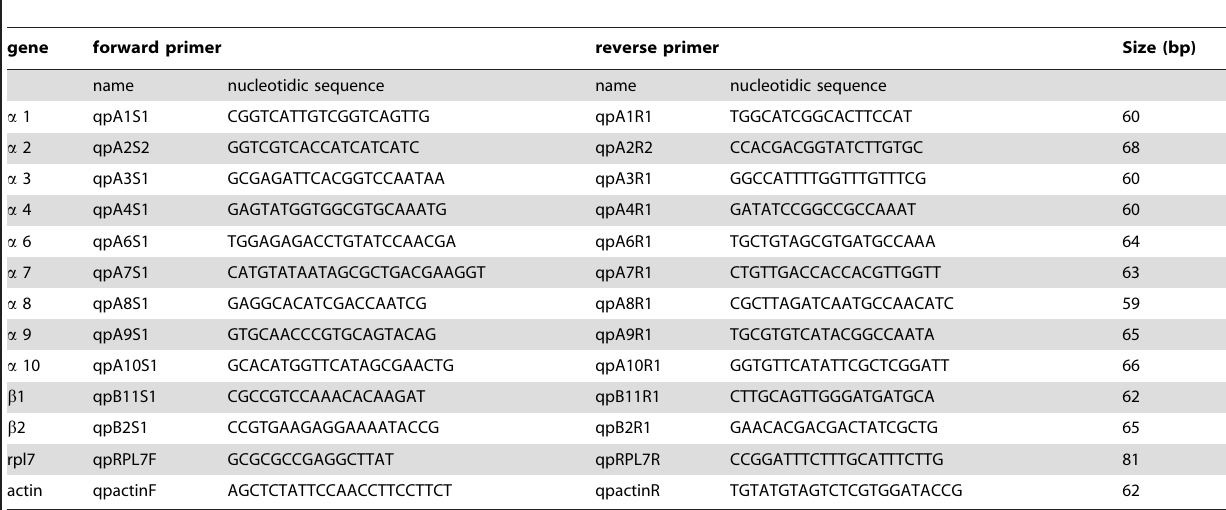
Table 2. Primers used to amplify nicotinic acetylcholine receptors subunits in quantitative PCR experiments.